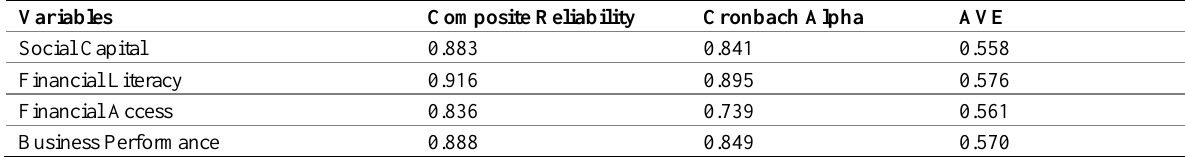
Table 1: Composite Reliability, Cronbach Alpha, AVE